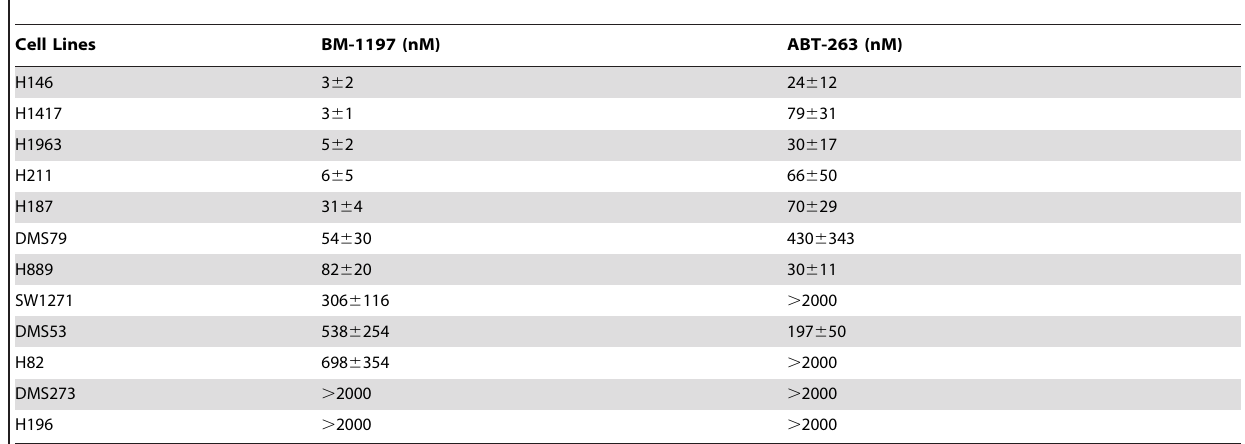
Table 1. Cell growth inhibitory activity of BM-1197 and ABT-263 against SCLC cell lines.